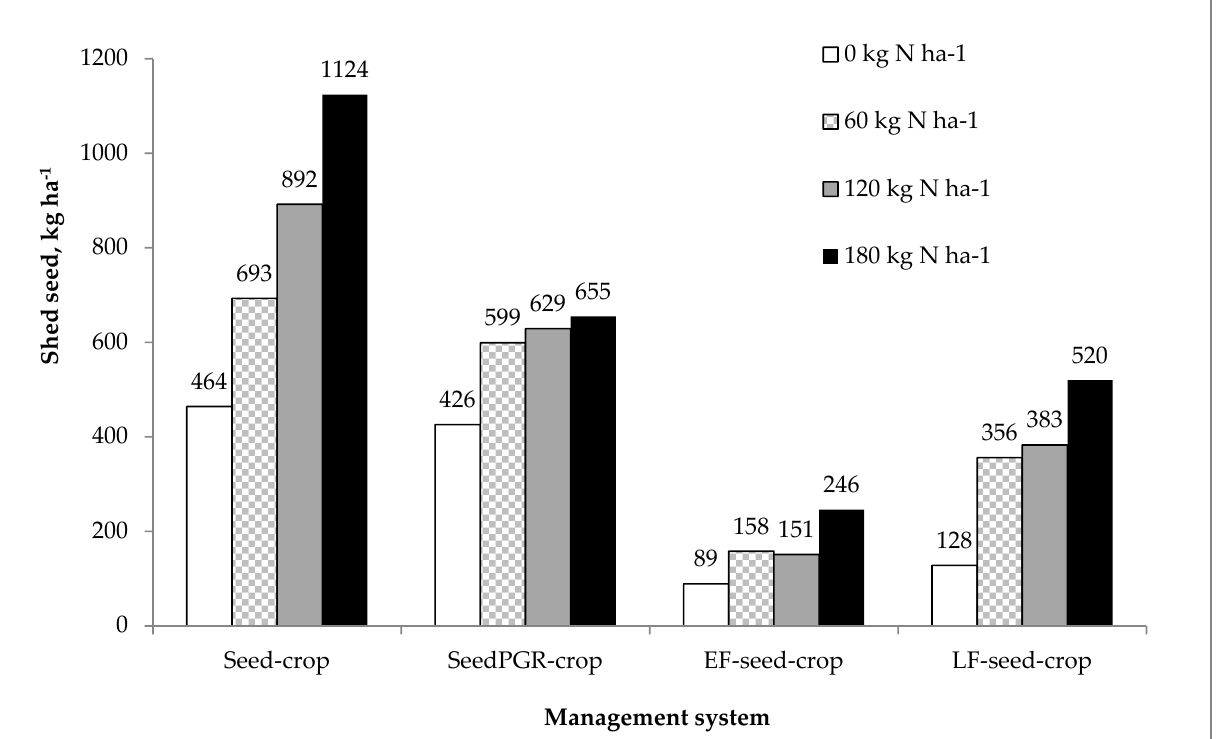
Figure 2. Effect of nitrogen (N) fertilization on seed shattering of Italian ryegrass crop grown under various management systems. LSD (0.05) = 240 kg ha -1 for comparing means within the same management system, LSD (0.05) = 318 kg ha -1 for comparing means within the same N fertilization, LSD (0.05) = 311 kg ha -1 for comparing means across management system and N fertilization.